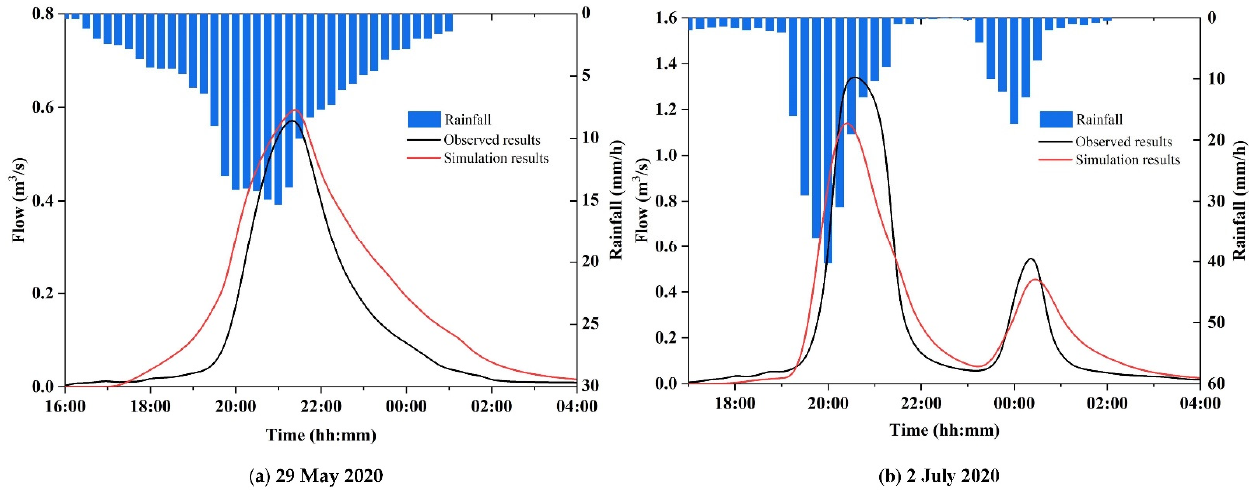
Figure 4. Comparison between simulated and observed flows. Table 3. Model validation results.